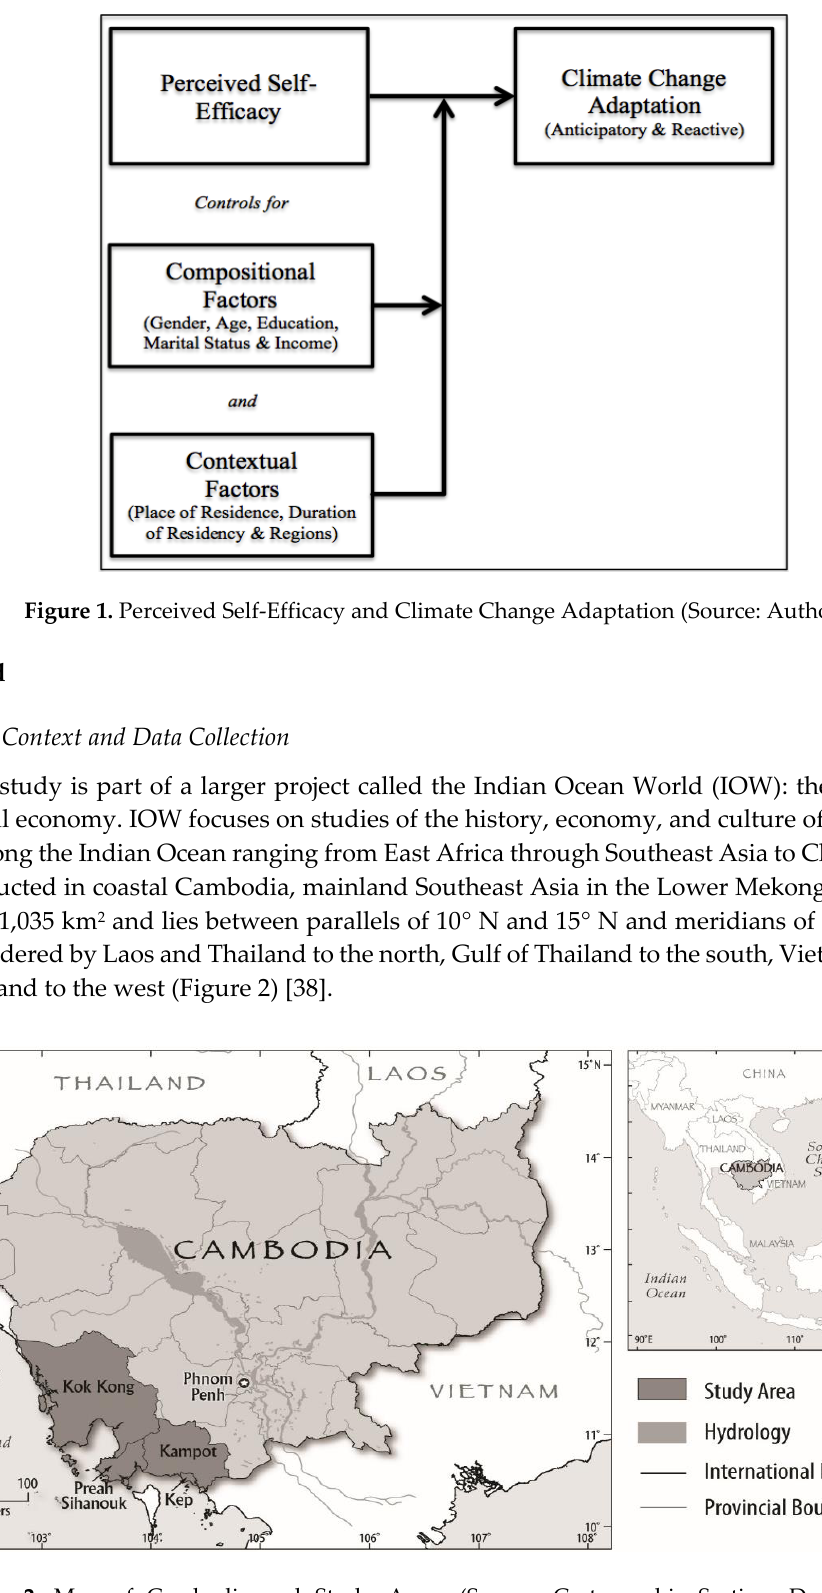
Figure 2. Map of Cambodia and Study Areas (Source: Cartographic Section, Department of Geography, Western